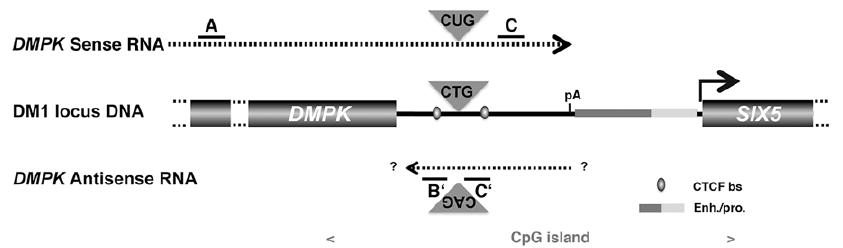
Figure 1. Schematic representation of the DMPK/SIX5 region. Dashed lines represent sense and antisense DMPK transcript. A, B 9 , C and C 9 represent the localization of amplicons used for qRT-PCR. CTCF bs: CTCF binding site; Enh/pro enhancer and promoter region. pA: polyadenylation site for the DMPK sense mRNA The SIX5 start site is indicated with an arrow. The location of the CpG island is indicated in grey. doi:10.1371/journal.pgen.1003043.g001 (Figure 3A). DMPK antisense RNA was also detected in a Using specific qRT-PCR and standard curves established with a commercial panel of normal human tissues with the highest levels known number of plasmid molecules coding the amplicons, we in heart and skeletal muscle (muscle type not specified) (Figure 3B). detected approximately 9, 3 and 3.5 fold more sense RNA than